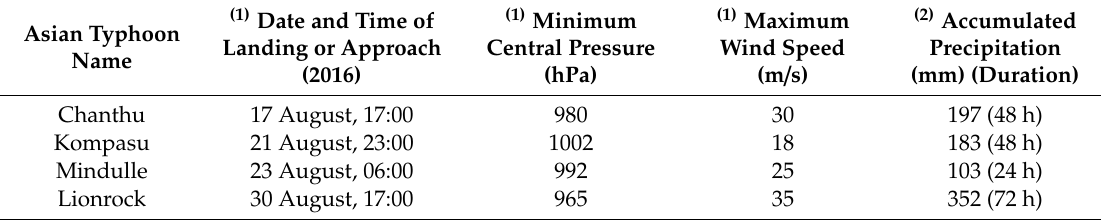
Table 1. Continuous multiple typhoon features.